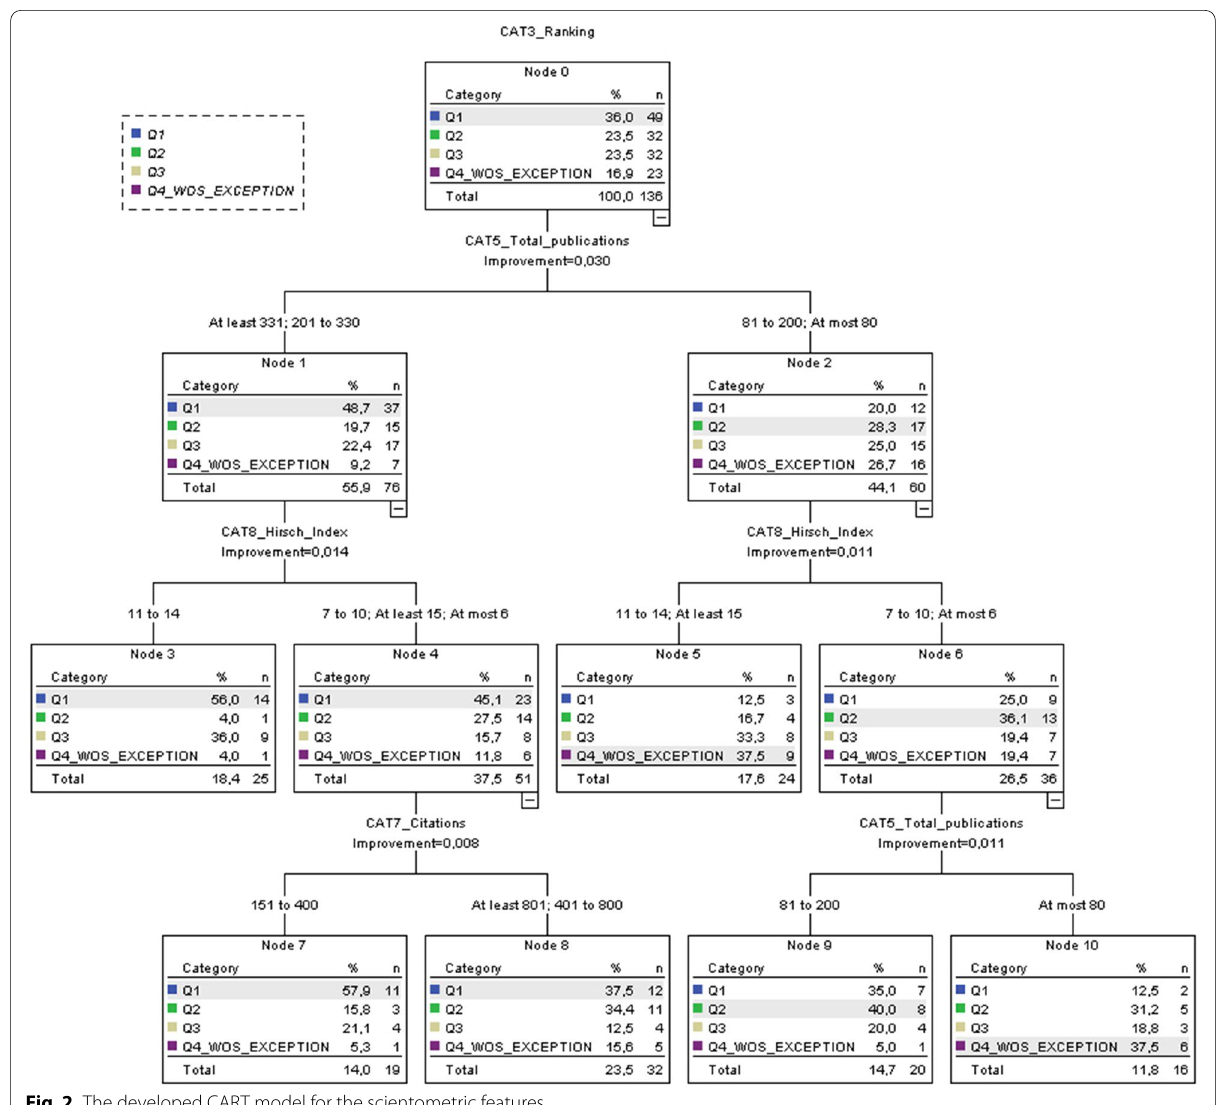
Fig. 2 The developed CART model for the scientometric